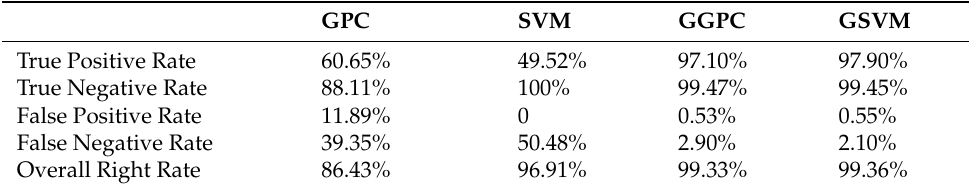
Table 8. Performance of the classifiers on the cut-in